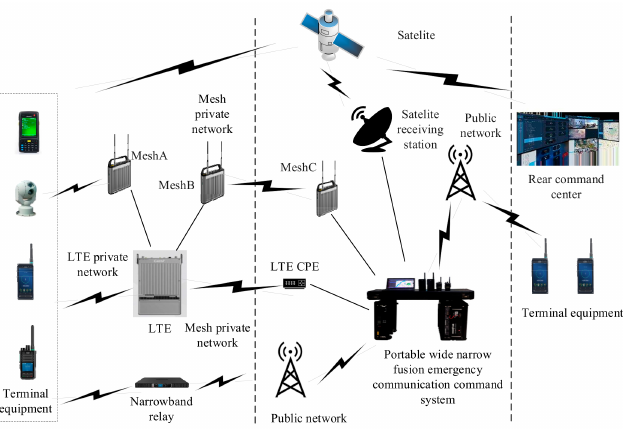
Figure 10. System topology of broadband-narrowband integrated emergency communication.